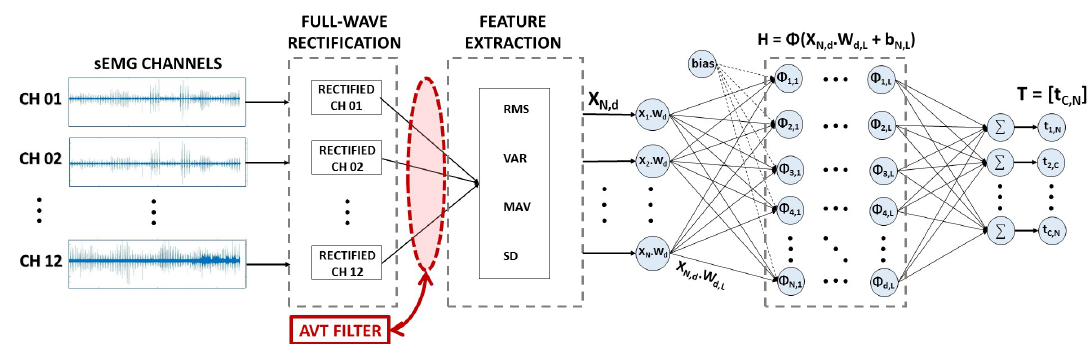
Figure 5. sEMG signal classification using a generic ELM classifier and the AVT filter. In this example, N is the number of samples to classify in C classes using d features and L hidden